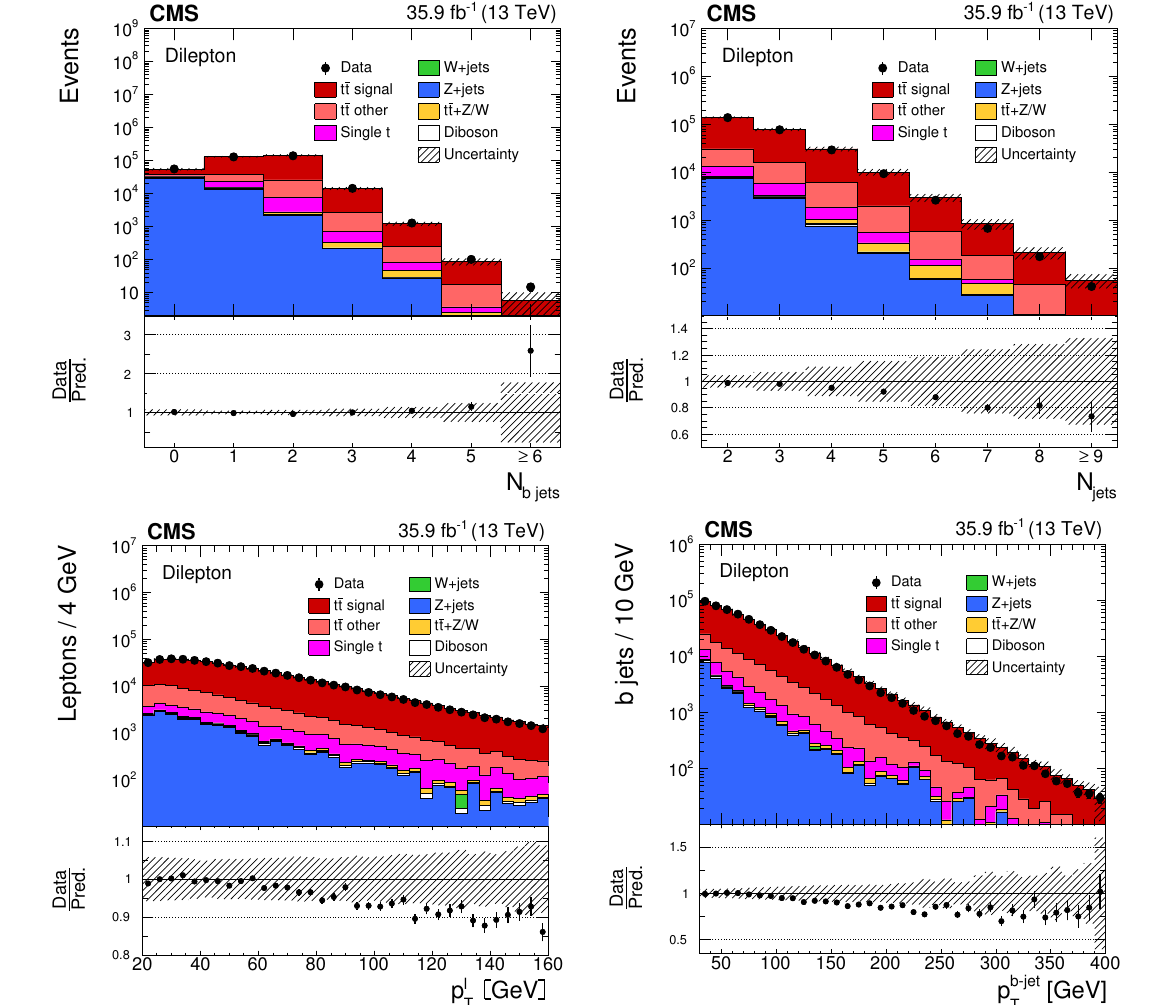
Figure 1 . Distributions of the b jet (upper left), and total jet (upper right) multiplicities, and the p T of the leptons (lower left), and b jets (lower right) are shown for data (points) and simulation (histograms). The tt process is simulated with powheg + pythia . The vertical bars on the points represent the statistical uncertainties in the data. The hatched regions correspond to the systematic uncertainties in the signal and backgrounds, as described in section 6. The lower panel of each plot shows the ratio of the data to the predictions from simulation. cross section is obtained by dividing the absolute di(cid:11)erential cross section by the measured total cross section (cid:27) in the same phase space, which is evaluated by summing the binned cross section measurements over all bins of the observable X . The background from other tt decays is taken into account, after subtracting all other background components, by correcting the number of signal events in data using the expected signal fraction. The expected signal fraction is de(cid:12)ned as the ratio of the number of selected tt signal events to the total number of selected tt events in simulation. This procedure avoids the